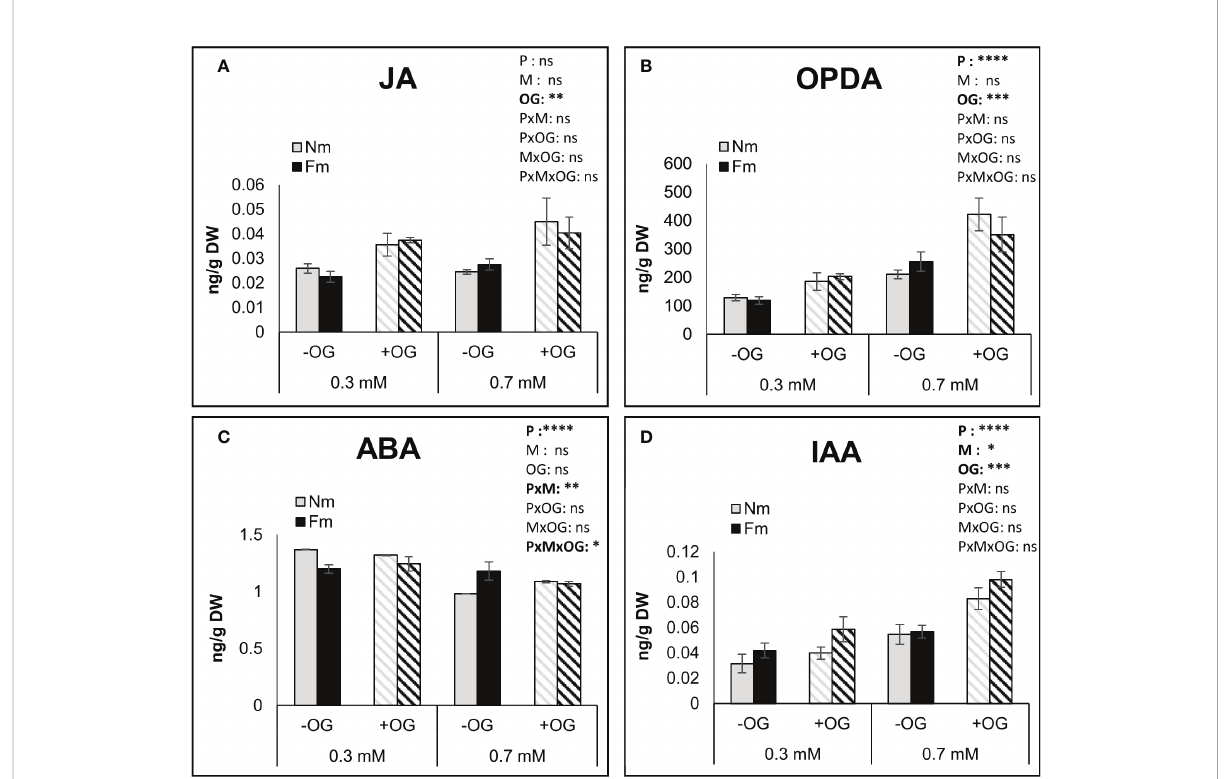
FIGURE 4 Impact of OG treatment on the content of defense-related phytohormones in tomato leaves. Targeted analysis of phytohormones in non- mycorrhizal (Nm) and mycorrhizal tomato plants colonized by ( F ) mosseae (Fm) grown under 0.3 mM or 0.7 mM P fertilization. The fourth true leaf of each plant was sprayed with 50 m g/ml OG solution (+OG; stripped bars) or water for the control (-OG; fi lled bars) and harvested at 6h post elicitation. (A) JA, (B) OPDA, (C) ABA and (D) IAA were quanti fi ed by UPLC-MS/MS in tomato leaves. Data represent the means of 6 independent biological replicates ± SD. Three-way ANOVA using P fertilization (P) mycorrhizal (M) and OG treatments (OG) as factors was performed and signi fi cance is indicated in the upper right corner of each graph. Asterisks denote signi fi cant effect of a factor or their interaction. ns: no signi fi cant; *:p < 0.05; **:p < 0.01; ***:p < 0.001; ****:p <